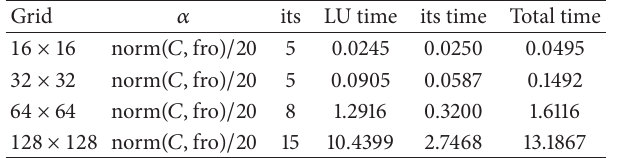
Table 6: Preconditioned GMRES(20) on steady Oseen problems with different grid sizes (uniform grids), viscosity V = 0.1 .